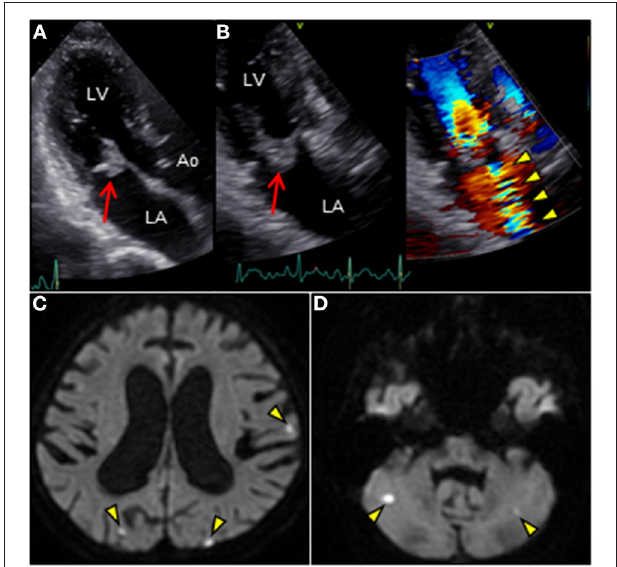
FIGURE 1 | (A,B) Transthoracic echocardiography in apical three-chamber view reveals an irregular mass (18 × 17mm, arrow) attached to the atrial side of the anterior mitral leaflet. Color Doppler image reveals massive mitral regurgitation traversing the mass (arowheads). (C,D) Brain diffusion-weighted magnetic resonance imaging reveals multiple acute hyperintense ischemic strokes in both hemispheres (arrowheads). Ao, aorta; LA, left atrium; LV, left